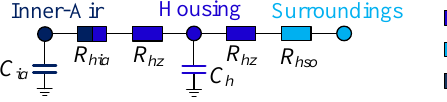
Figure 15. Housing thermal model.